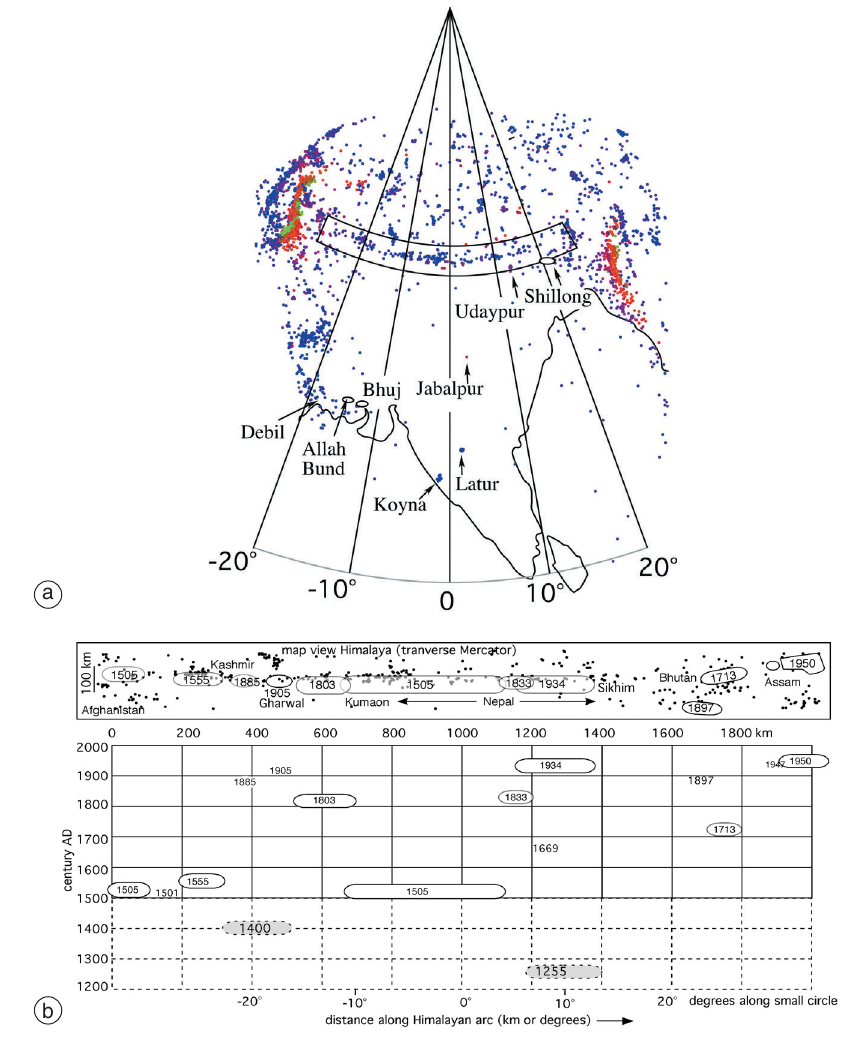
Fig. 4a,b. a) The Himalaya describe a small circle that subtends an arc of approximately one radian symmet- rically about the Thakola Graben in Tibet. Important mid-plate earthquakes named. Microseismicity follows this small circle (from Engdhal et al. , 1998) and is negligible to its south where great earthquakes are located. b) The arcuate box is expanded (and straightened) and it shows time distance plot of approximate rupture areas of large earthquakes in the past eight centuries plotted along the arc (approximate transverse-Mercator projection of lin- ear transverse-km versus angular distance). One or more large earthquakes appear to be overdue in Kashmir, Ku- maon and Western Nepal. We know of no earthquakes in Sikkim, and the 1897 Assam Shillong earthquake may have reduced the slip potential in Eastern Bhutan. Pre-1500 earthquakes are known with less certainty. Trench studies have revealed slip on the frontal thrusts at the beginning of the 15th century at several locations west of Dehra Dun (Senthil Kumar, per. comm., 2004) and surface rupture on frontal thrusts in eastern Nepal may cor- respond to the earthquake that destroyed Kathmandu in 1255 (Rockwell, pers. comm.,